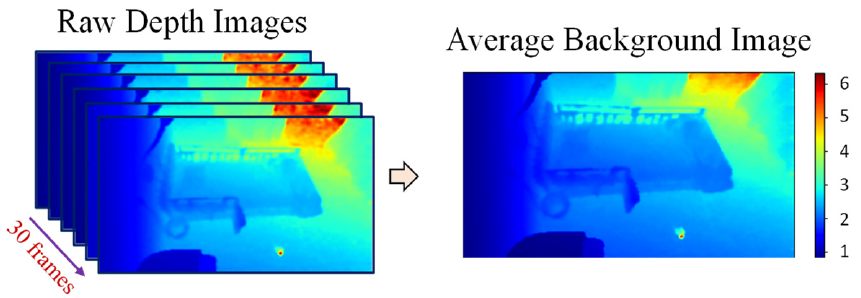
Figure 3. Average background image.